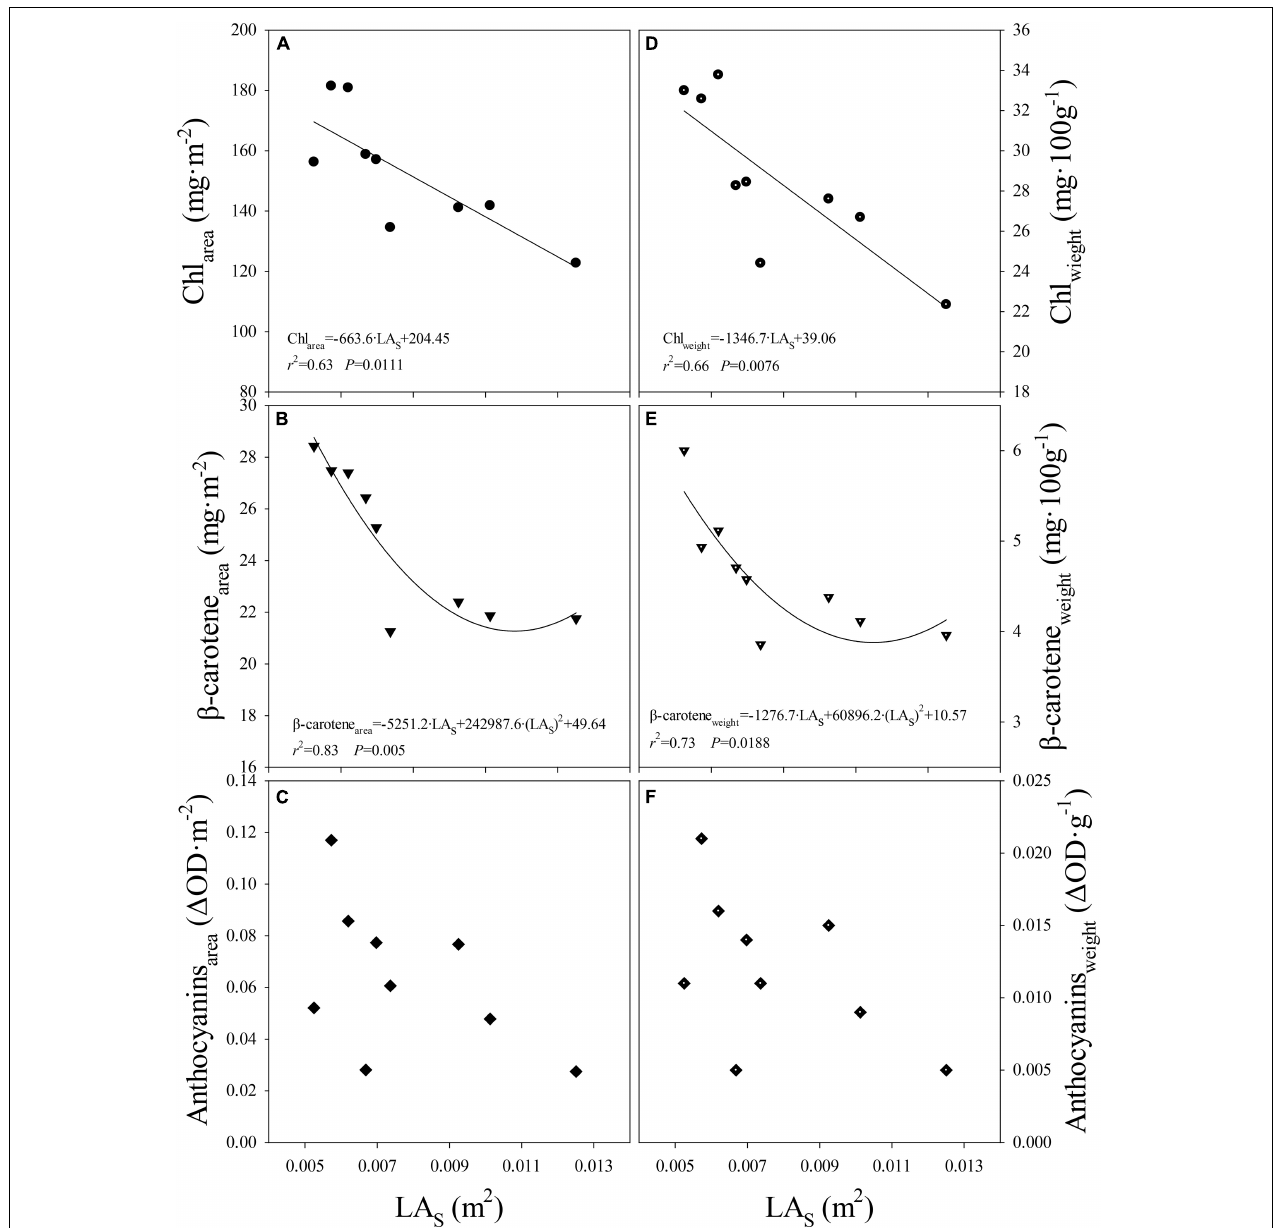
FIGURE 5 | Relationship between (A) level of chlorophylls per unit leaf area (Chl area ) and average area of a single leaf (LA s ), (B) level of beta-carotene per unit leaf area ( β -carotene area ) and LA s , (C) level of anthocyanins per unit leaf area (Anthocyanins area ) and LA s , (D) levels of chlorophylls per unit fresh weight (Chl weight ) and LA s , (E) level of beta-carotene per unit fresh weight ( β -carotene weight ) and LA s , (F) level of anthocyanins per unit fresh weight (Anthocyanins weight ) and LA s in romaine lettuce. Data from three light treatments and three replications per treatment are shown. A linear regression was fitted to data in panels (A,D) and a quadratic regression was fitted to data in panels (B,E)